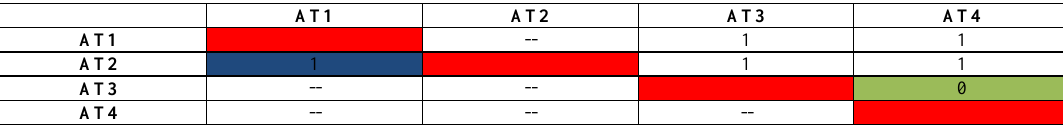
Table 19. Dominating interaction matrix of actors for process PR4.